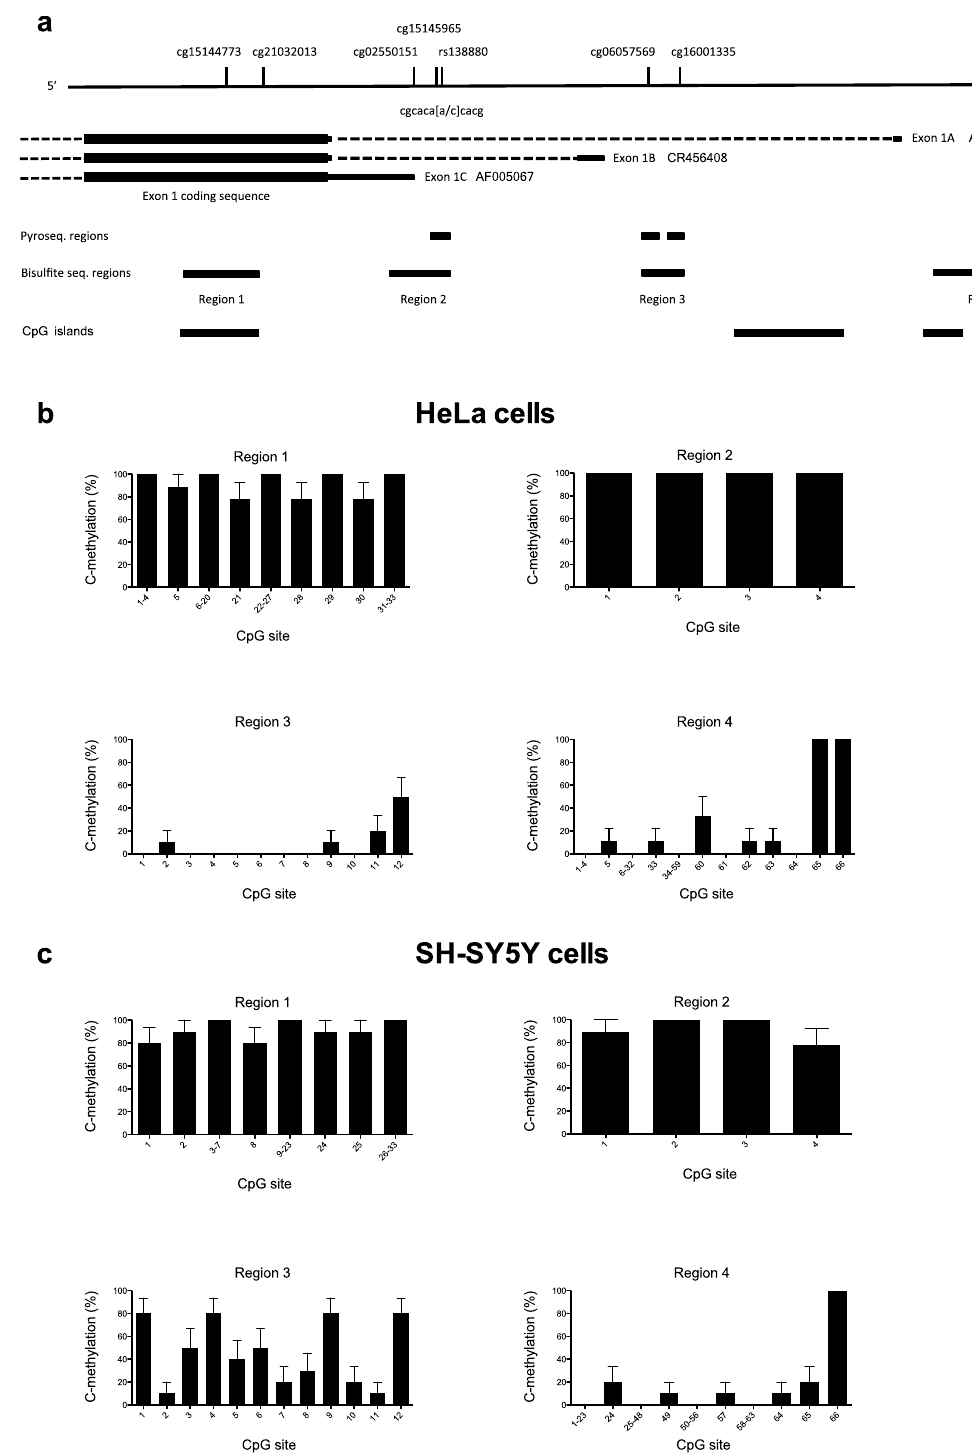
Fig 1. Structure of the BRD1 promoter regions and methylation proportions in region 1–4 in cell lines. (a) Structure of the BRD1 promoter regions. BRD1 comprises 12 coding exons with the first coding exon 1 illustrated in the figure. BRD1 was initiallydescribedto feature two splice variants, a long and a short resultingfrom alternativesplicing of exon 7 and with transcription initiatedfrom respectively,exon 1 with a 487 bp 5’ UTR (exon 1C) or from a non-coding exon locatedmore than 3 kb upstream of the common exon 1 (exon 1A). We confirm the presence of a third